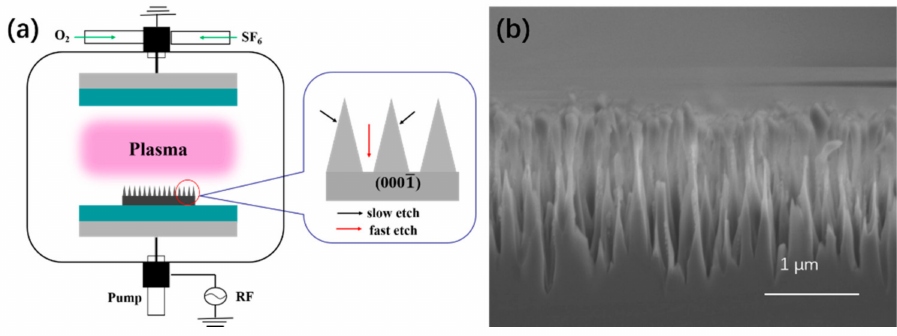
Figure 1. ( a ) Schematic diagram of RIE etching 4H-SiC wafer substrate and ( b ) cross-section of scanning electron microscope (SEM) image after RIE etching for 20